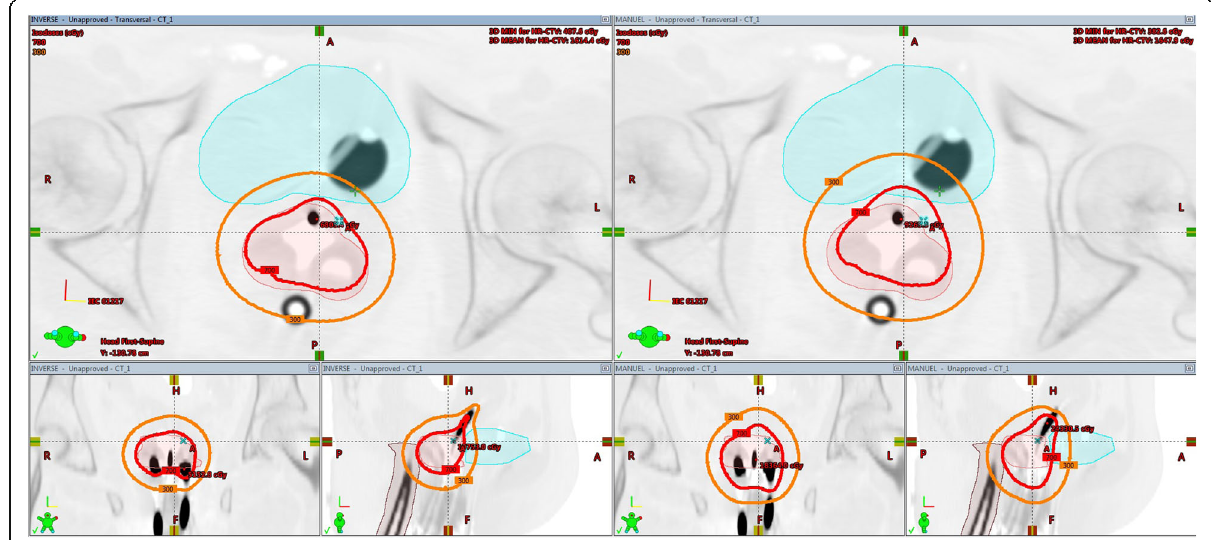
Fig. 2 The comparison of dose distribution between IO plan and MO plan